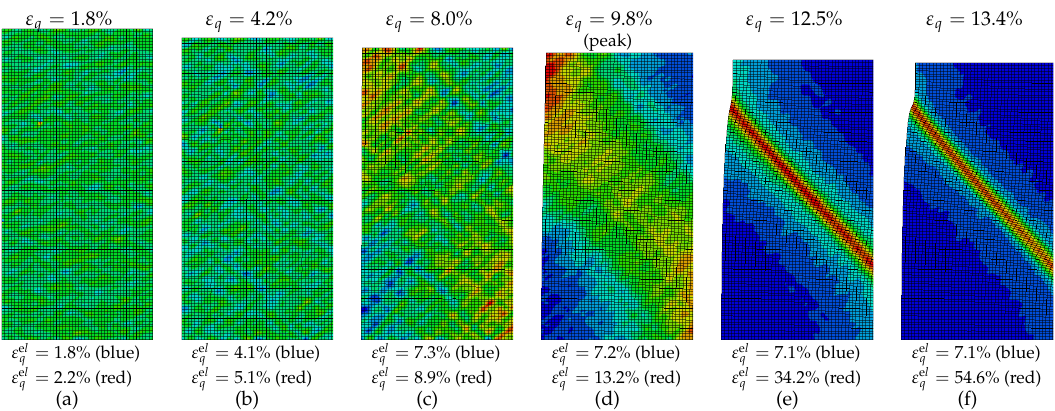
Figure 6. OCR = 1.5: Shear band development displayed with deviatoric strain in each element ε el q at different global deviatoric strain ε q , peak in q is at ε q = 9.8%. ( a – c ) show pre-peak pattern of shear bands, ( d ) peak and ( e , f ) post-peak pattern of shear bands. ε q = 3.2%